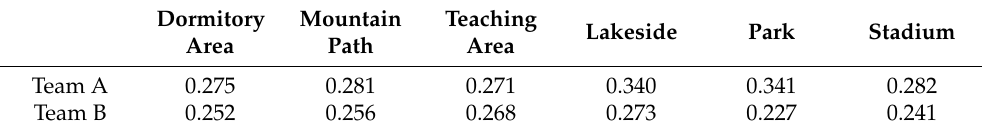
Table 4. Standard deviations of two-dimensional ISO coordinate